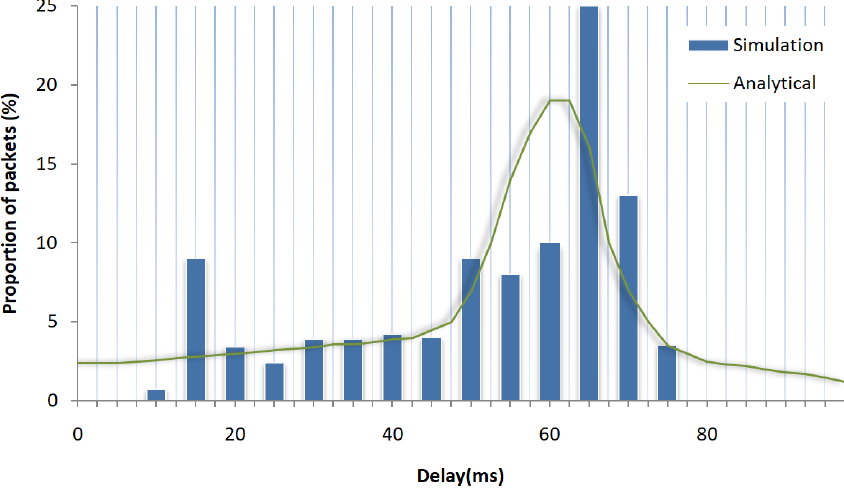
Figure 4. Dependence of the proportion of packets at the end-to-end network delay of the system.